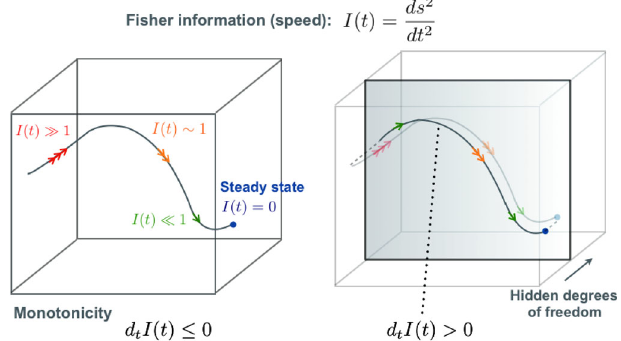
FIG. 2. Illustration of the nonmonotonic behavior of the Fisher information in the presence of hidden degrees of freedom. The relaxation of the system towards the steady state traces a path in the (in this case, three-dimensional) state space. In the full state space (left diagram), this relaxation is accompanied by a monotonic decrease of the temporal Fisher information (i.e., the speed of the relaxation process), as indicated by the arrows along the path. Tracing out the hidden degrees of freedom corresponds to a projection of the path into a lower-dimensional subspace (shaded, right diagram). In this example, the initial relaxation process is mostly in the direction of the hidden degrees of freedom, resulting in an apparently slower speed in the projected dynamics and thus in a nonmonotonic behavior of the Fisher